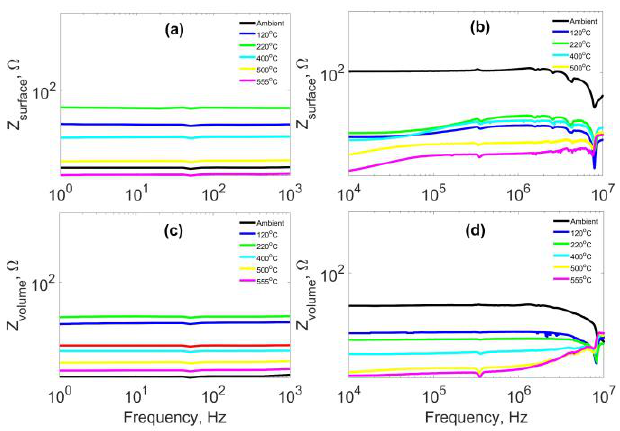
Figure 10. Surface and volume parametric impedance of the char material measured under a higher temperature over a wide frequency. ( a ) Surface impedance at low frequencies (1 Hz to 10 3 Hz); ( b ) surface impedance at high frequencies (10 4 Hz to 10 6 Hz); ( c ) volumetric impedance at low frequencies (1 Hz to 10 3 Hz); ( d ) volumetric impedance at low frequencies (10 4 Hz to 10 6 Hz).